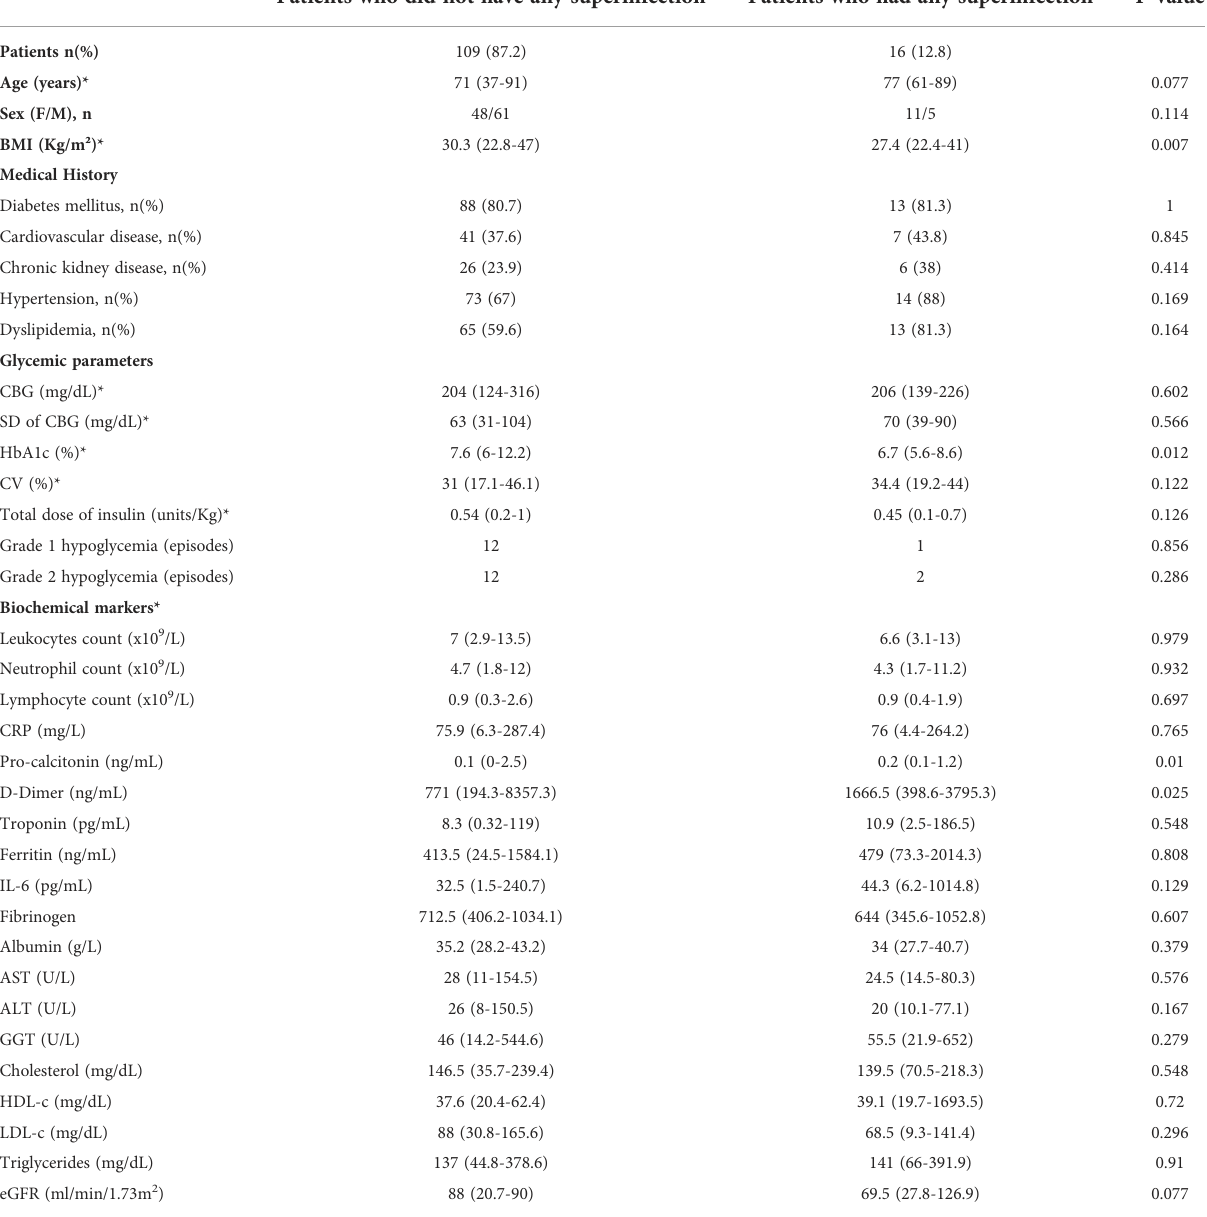
TABLE 3 Baseline clinical characteristics and glycemic parameters between patients with diabetes mellitus related to superinfections. Patients who did not have any